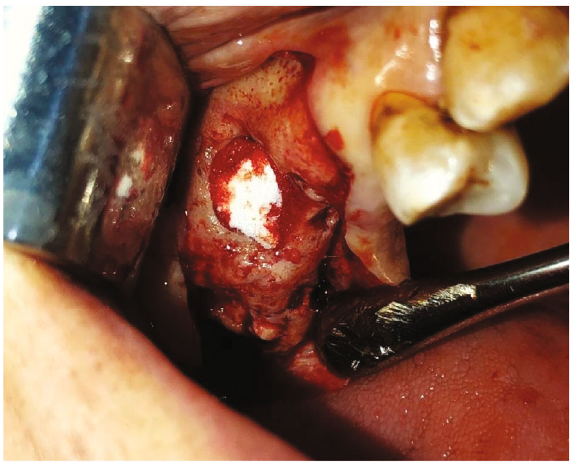
Figure 4: Intraoral view showing the closure of the OAC by a collagen membrane.